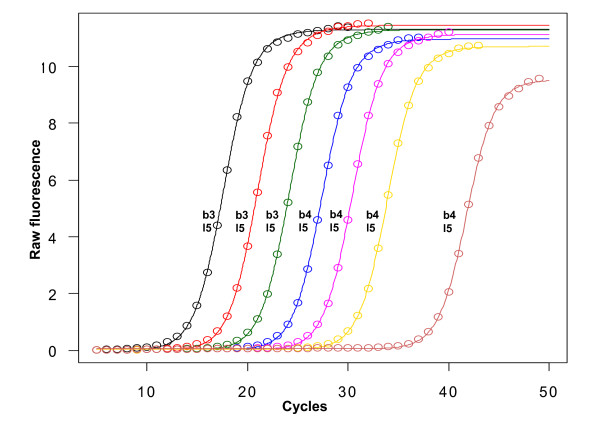
Model selection of logistic fits on a qPCR dilution experiment. Three-, four- and five-parameter logistic ('b3'-'b5') and log-logistic ('l3'-'l5') models were fit onto the average of quadruplicate S27a amplification curves of a 10-fold dilution experiment. The best models among the logistic models and log-logistic models were selected by nested F-tests using the residual variance as the criterion and are displayed in black letters near the curves. Coloured circles indicate experimental measurements.